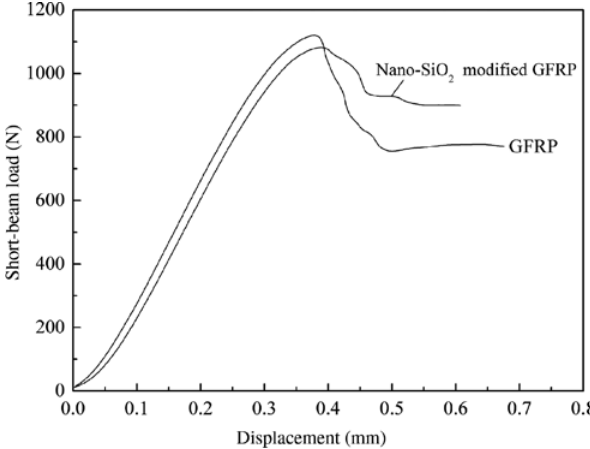
Figure 5: Typical load-displacement curves of the GFRP and nano- SiO modified GFRP under the short-beam load condition. 2